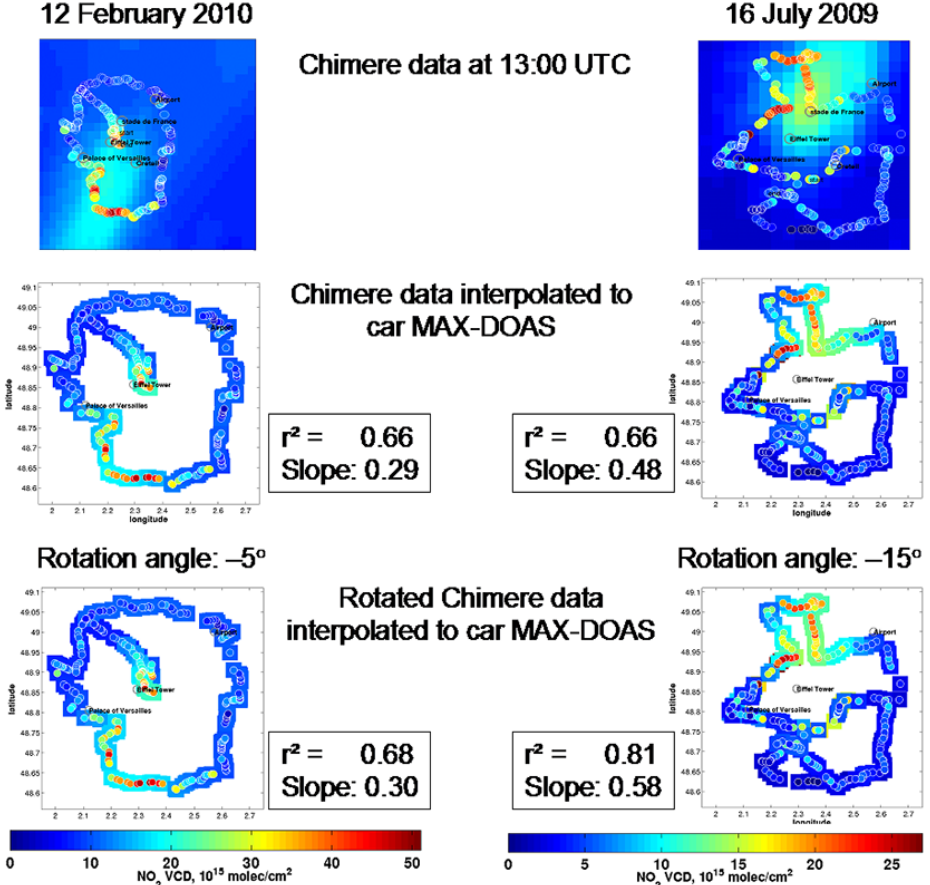
Figure 5. Comparison of car-MAX-DOAS observations with model results for 12 February 2010 (left) and 16 July 2009 (right). Top: CHIMERE data at the centre time of the car-MAX-DOAS observations (13:00); middle: CHIMERE data interpolated in space and time to match the individual car-MAX-DOAS observations; bottom: rotated CHIMERE data interpolated to the car-MAX-DOAS observations.